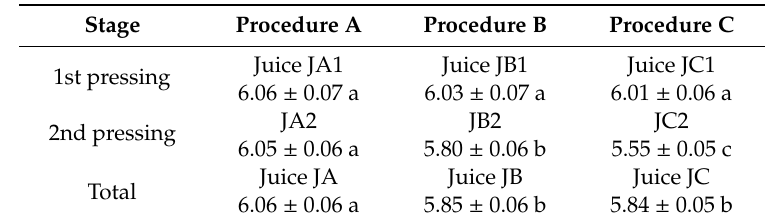
Table 4. pH of juice from celeriac root chips according to the selected procedure and pressing stage. Abbreviations as on Figure